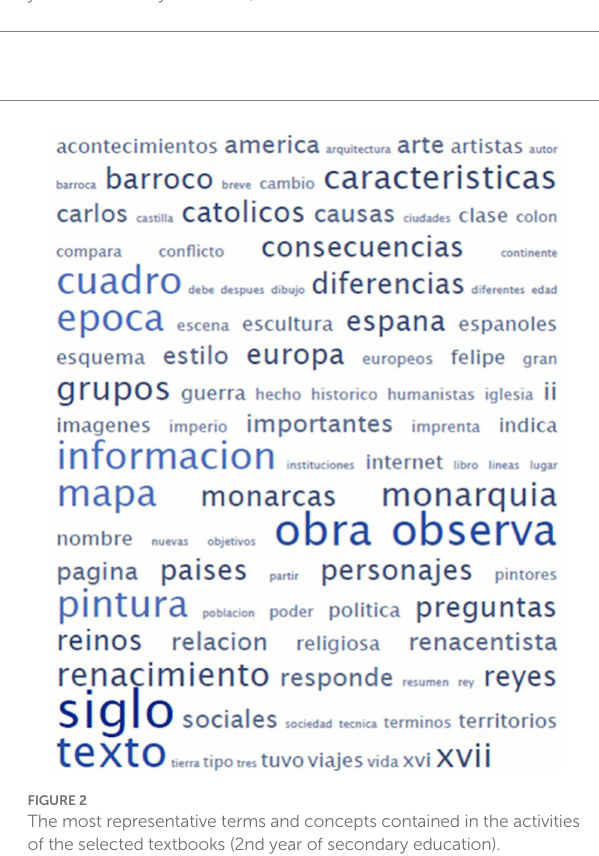
FIGURE 1 Relationship between the type of historical contents and the cognitive level of activities relating to the Early Modern Age in textbooks (2nd year of secondary education).